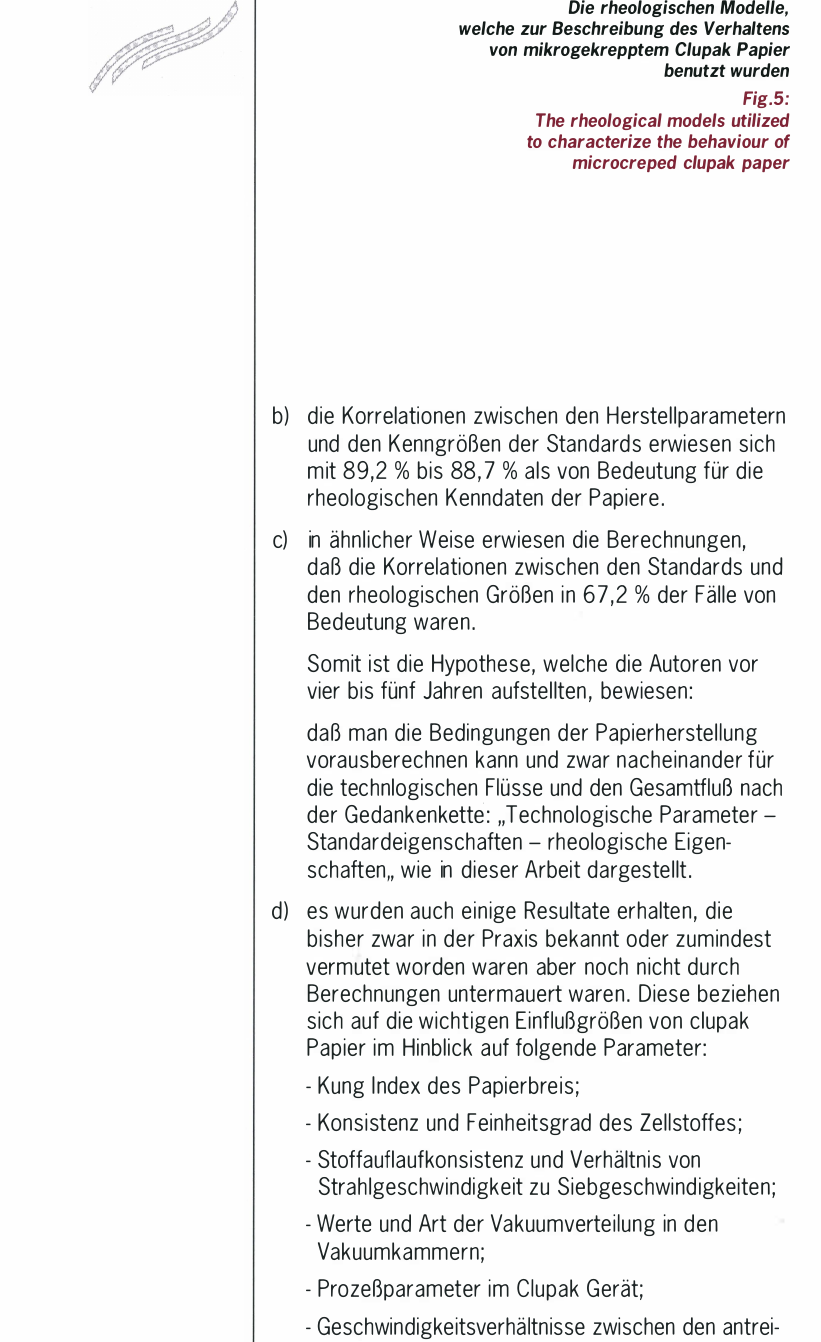
Fig.5: The rheological models